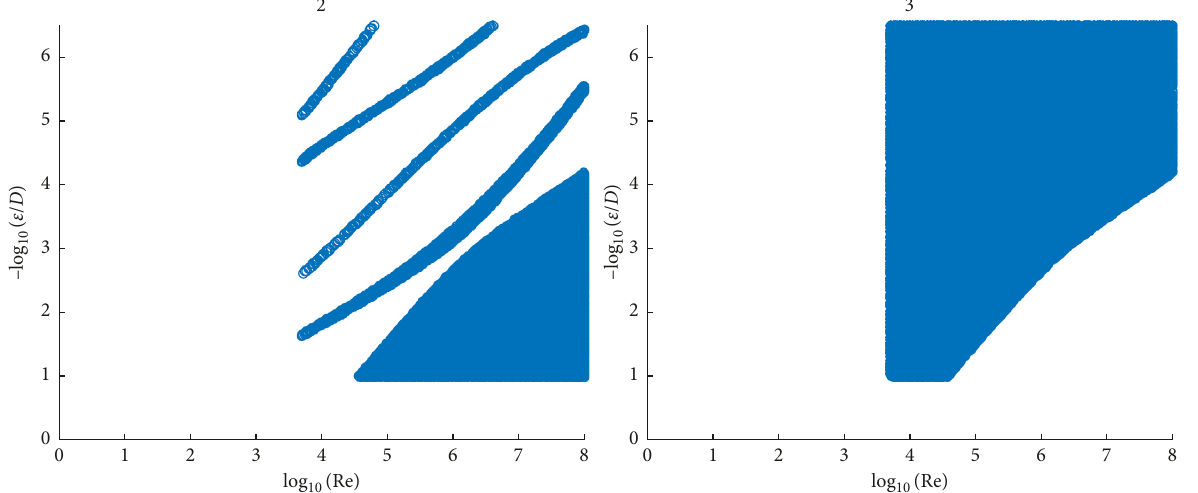
Figure 2: Area in which 2 iterations (left) and 3 iterations (right) are sufficient to calculate the flow friction factor λ with accuracy of 10 with error of up to